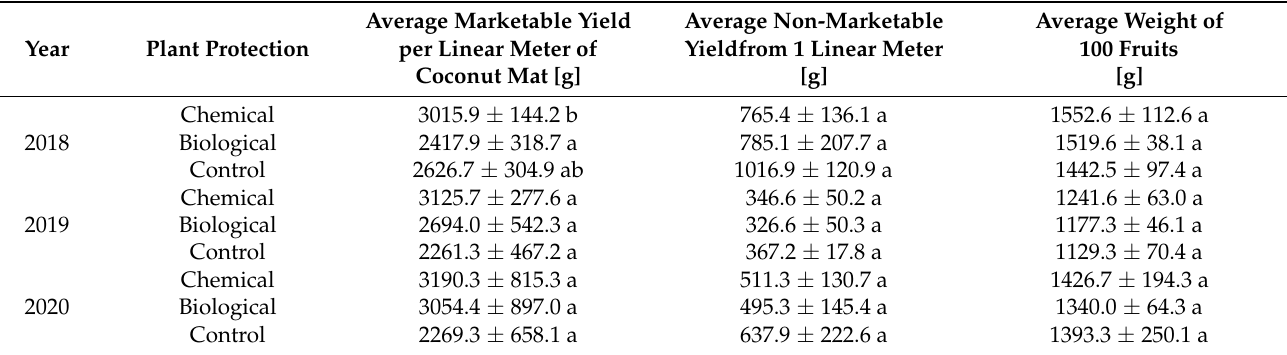
Table 3. Fruit yield of ‘Murano’ directly after